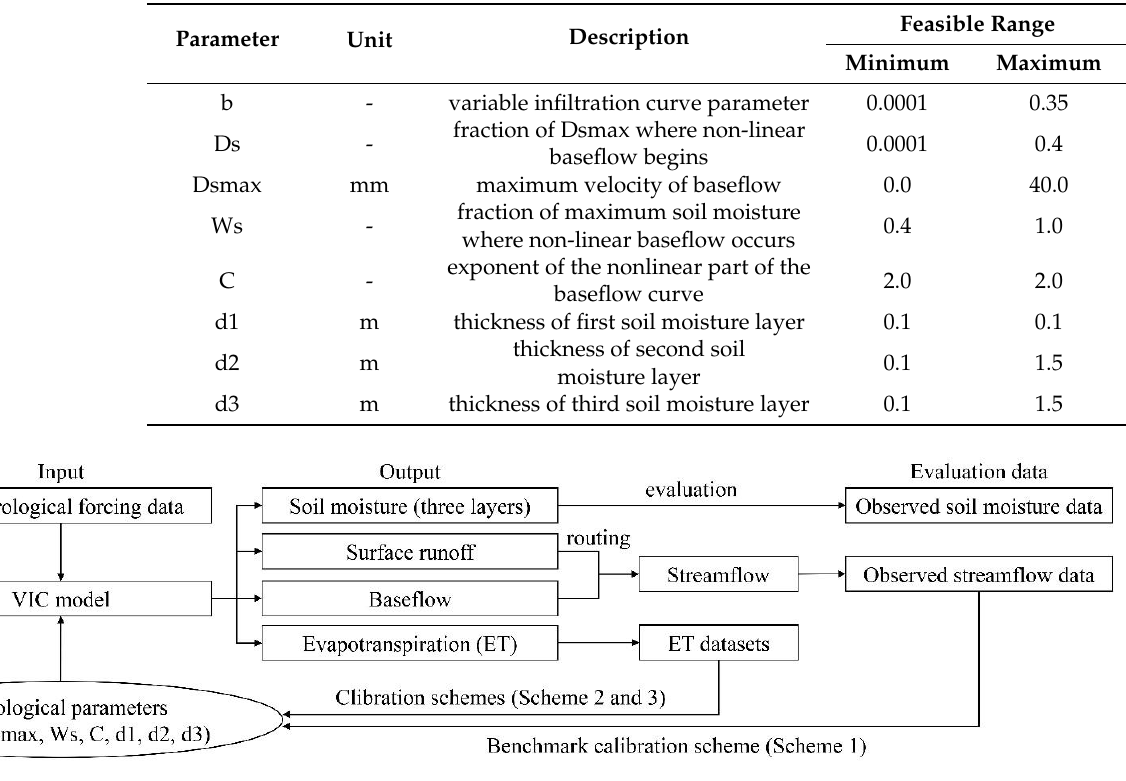
Table 4. Hydrological parameters in the VIC model for calibration.